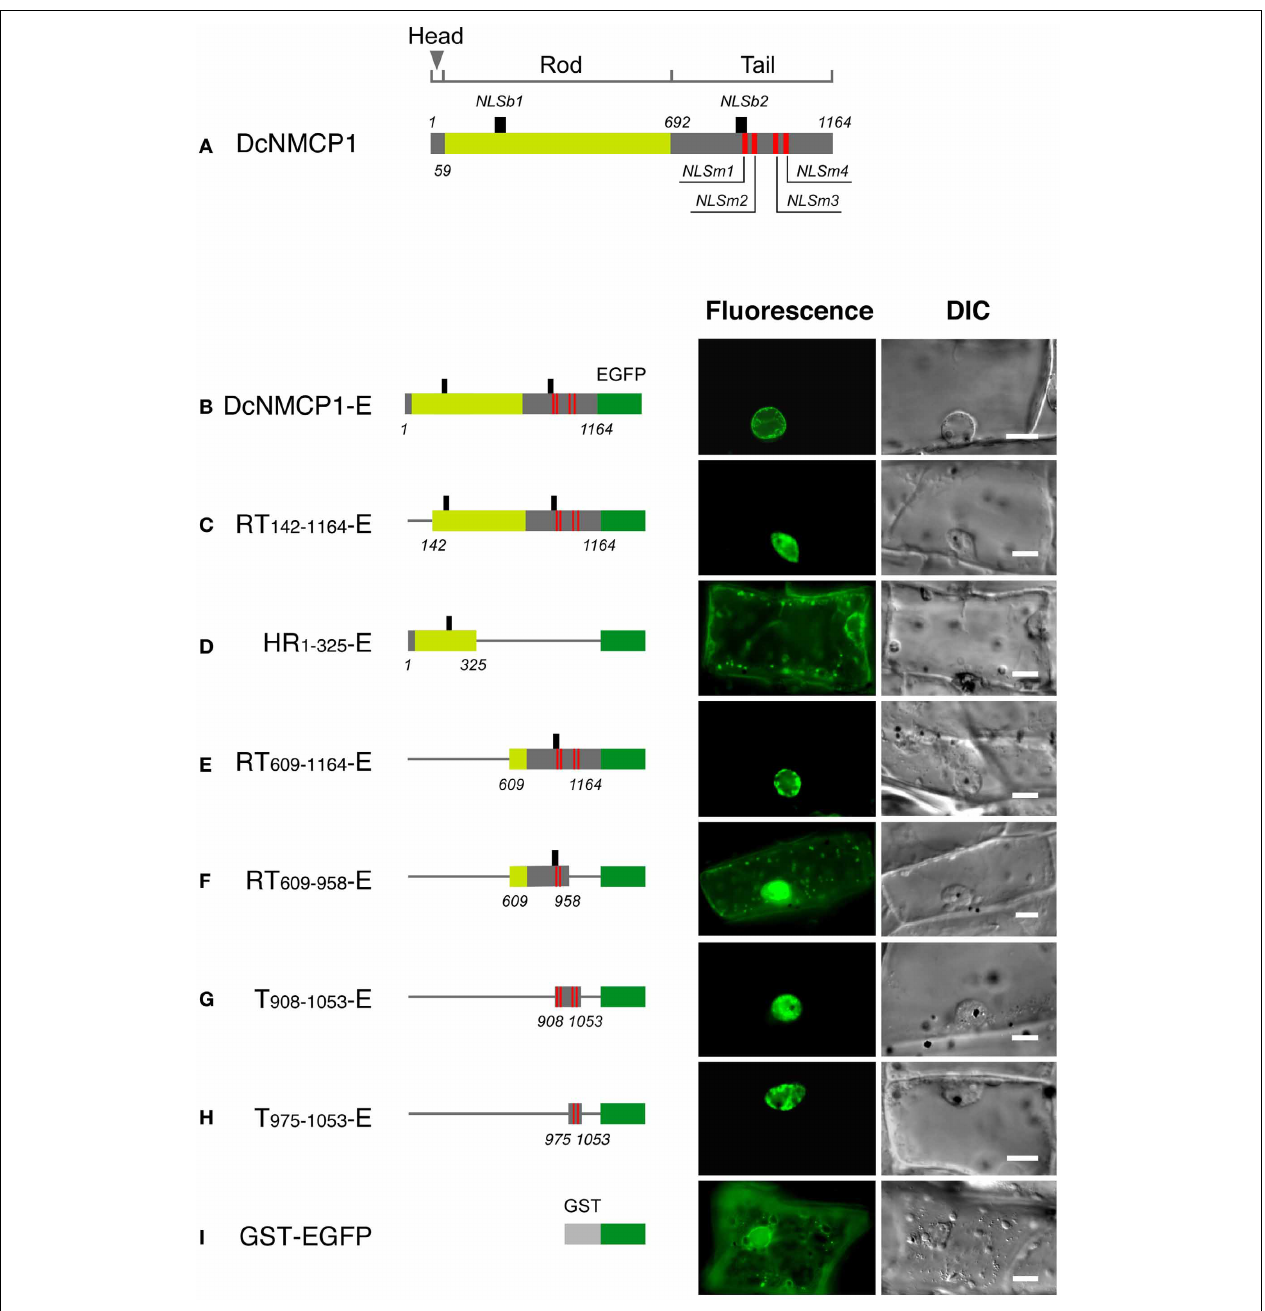
FIGURE 1 | The region of DcNMCP1 that functions to localize to the nucleus includes two NLS motifs. (A) Position of the putative NLS motifs in DcNMCP1. The SV-40 large T-antigen type and bipartite type NLS motifs are indicated by red and black vertical bars, respectively. The head (amino acids 1–58), rod (amino acids 59–69), and tail (amino acids 692–1164) domains are represented by different colors. Localization of the